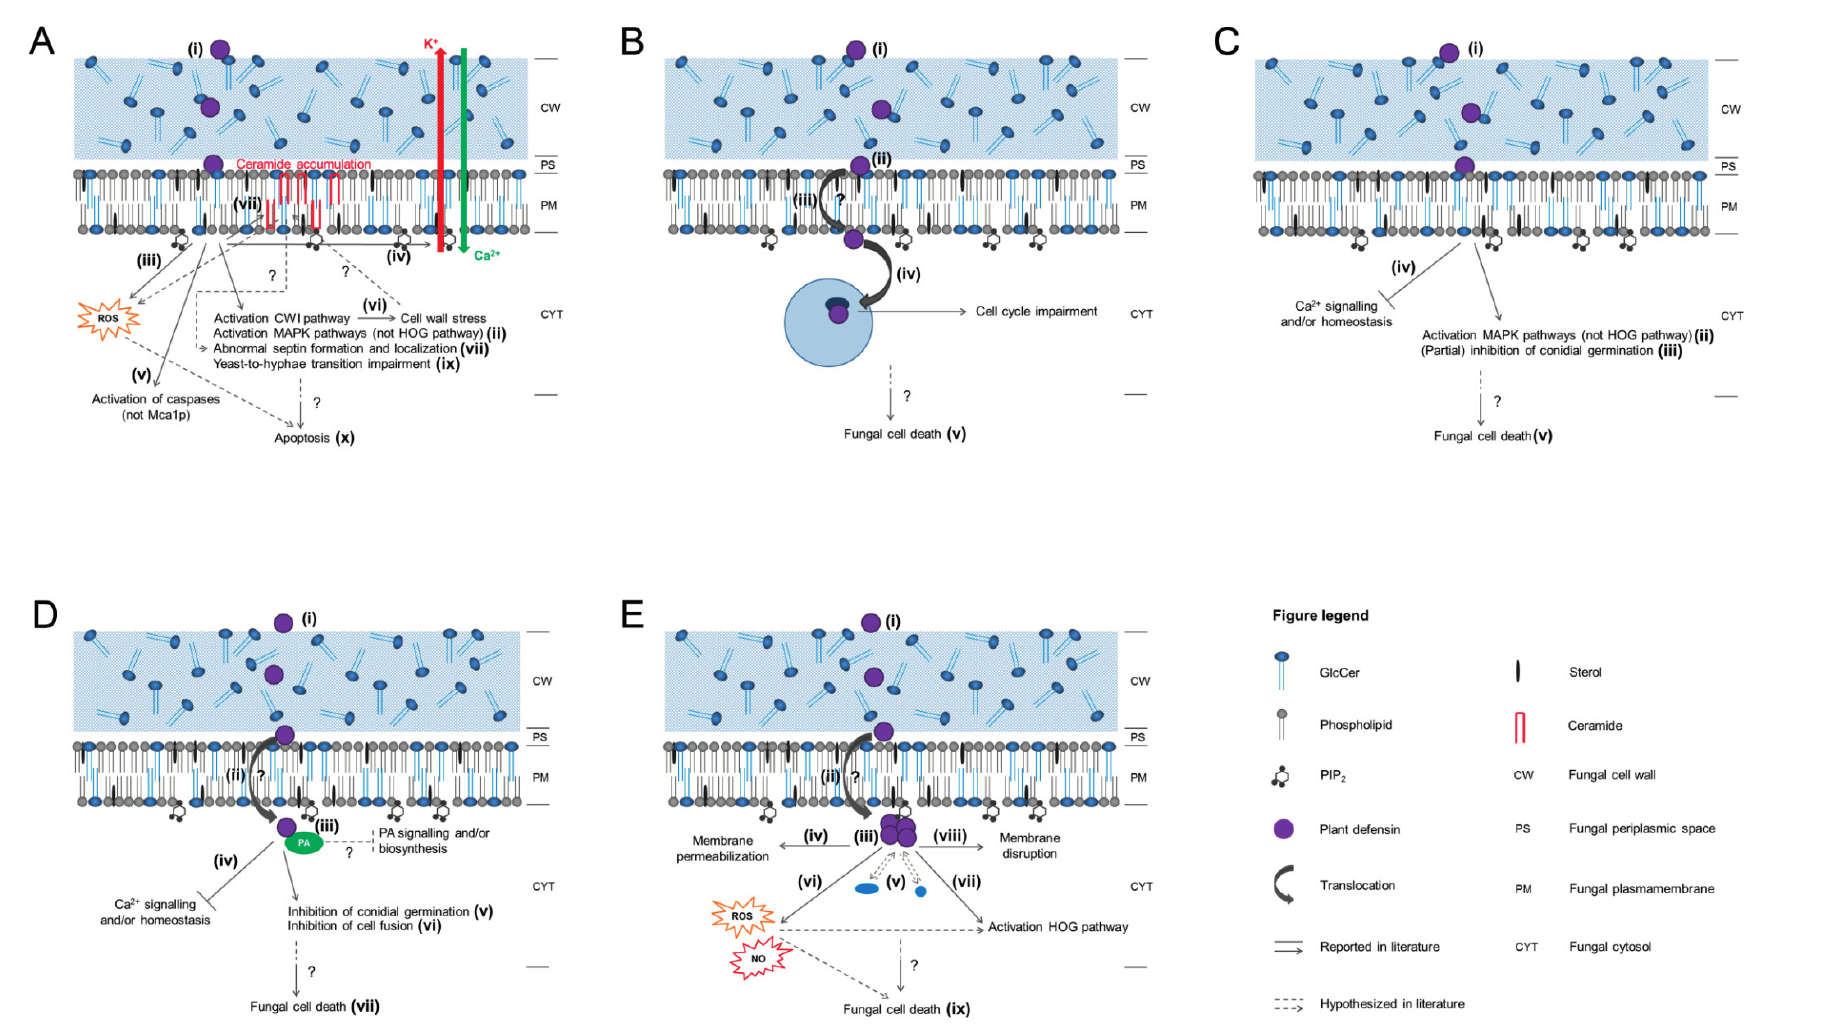
Figure 2. Schematic overview of the proposed mechanisms of action of the plant defensins discussed in this review. ( A ) RsAFP1 and RsAFP2; ( B ) Psd1; ( C ) MsDef1; ( D ) MtDef4; ( E ) NaD1. For detailed information on the Roman numerals displayed in the figures, the reader is referred to Section 3.1 ( A ), 3.2 ( B ), 3.3 ( C ), 3.4 ( D ) and 3.5 ( E ) of this